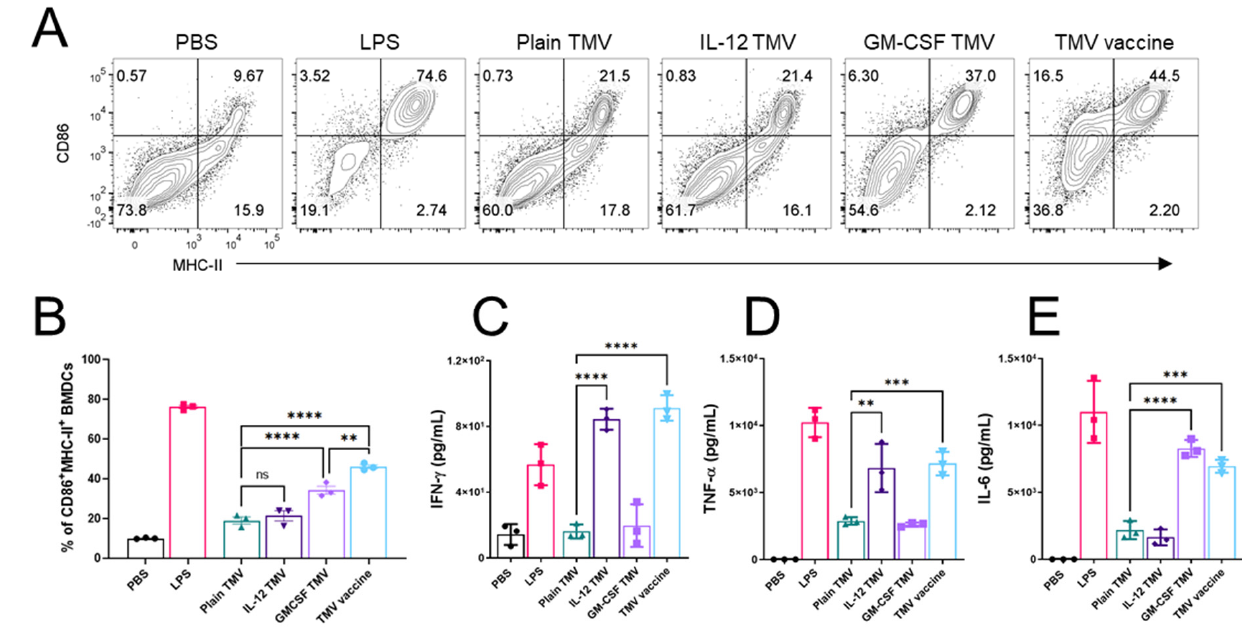
Figure 3. TMVs with GPI-ISMs induce DC activation and cytokine release. ( A ), Representative plots of surface levels of CD86 and MHC-II on BMDCs after stimulating with LPS (positive control), D2F2/E2 TMVs containing different GPI-ISMs, or unstimulated (PBS) for 24 hrs. ( B ), quantification from A percentage of CD86 + MHC-II + BMDCs after 24-h pulsing with TMVs. ( C – E ), ELISA of IFN- γ , TNF- α , and IL-6 levels in supernatants of BMDCs stimulated as in ( A ). Error bars represent SD. **, p < 0.001 ***, p < 0.0001 ****, p > 0.05 ns. Analysis in ( B – E ) done with a one-way ANOVA with Tukey’s post test for multiple comparisons.